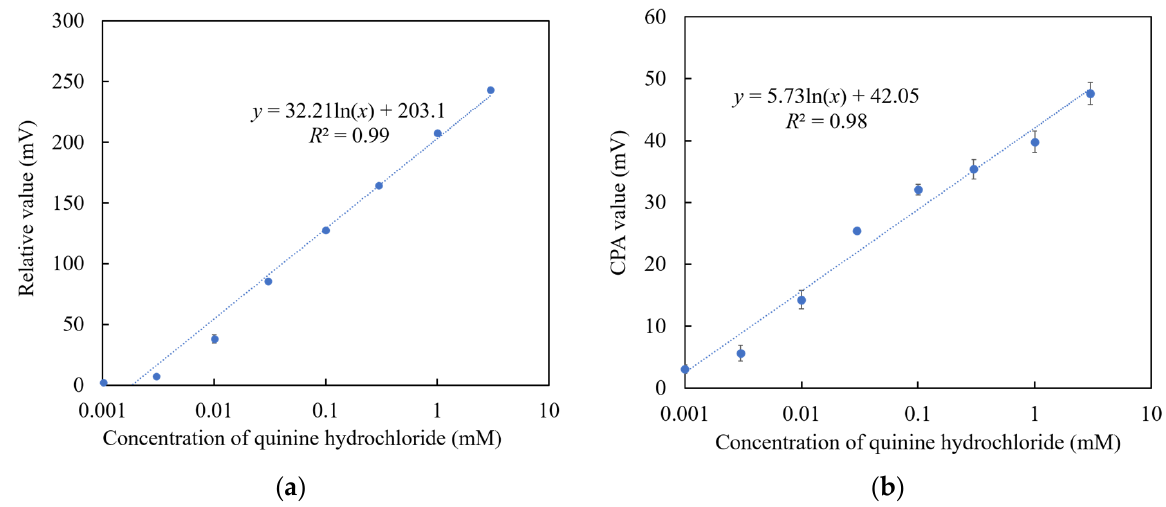
Figure 12. Concentration dependence of TFPB-NPOE sensor on quinine hydrochloride: ( a ) Relative values; ( b ) CPA values. The results are expressed as means ± SD ( n = 20, 4 membranes × 5 times).